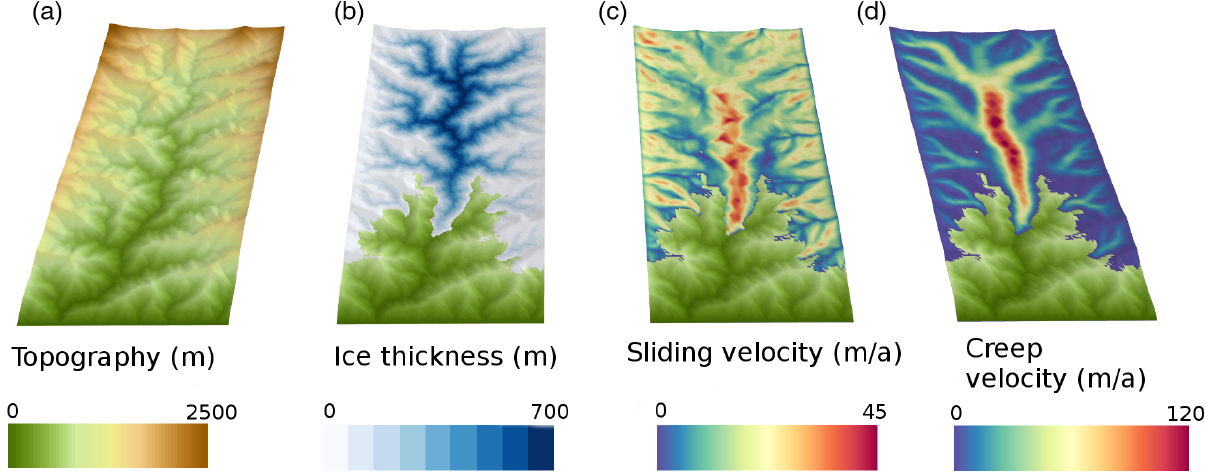
Figure 1. Bed topography (a) , steady-state ice thickness (b) , sliding velocity (c) , and depth-averaged creep velocity (d) for experiment 1. The velocities shown are from